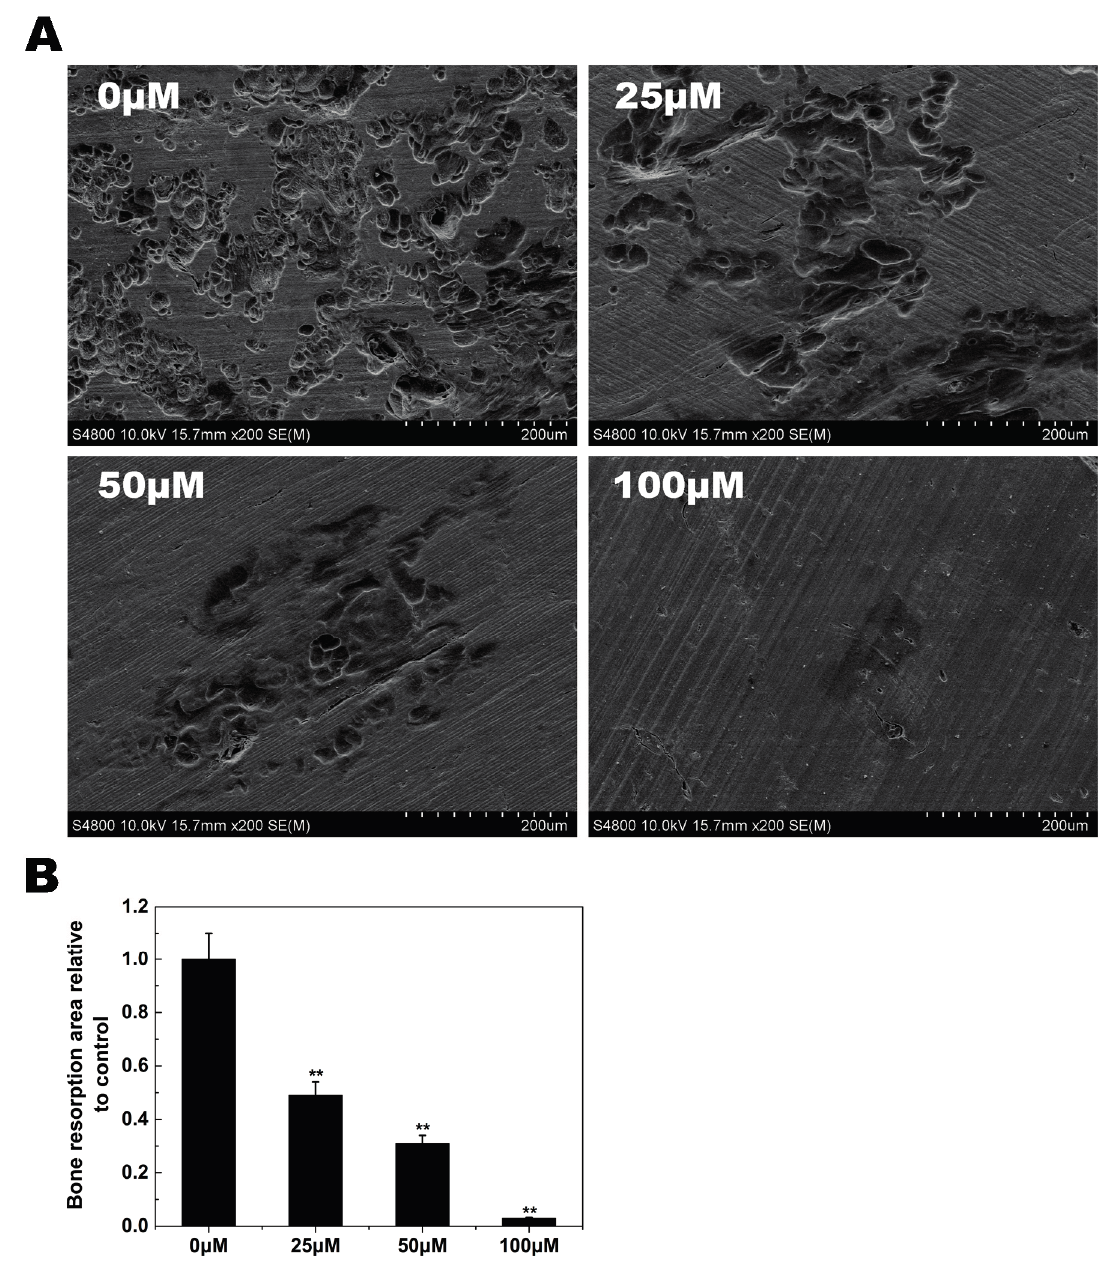
Figure 4. Naringenin (NAR) inhibited osteoclast-mediated bone resorption. Resorption pit areas were measured using ImageJ software (ImageJ software, Bethesda, MD, USA). All experiments were performed at least three times. ( A ) Representative scanning electron microscopy images of bone resorption pits; ( B ) The bone resorption area, relative to control. ** p <